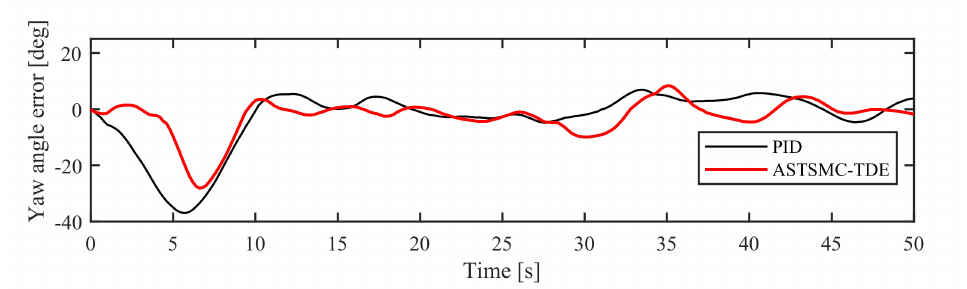
Figure 20. The experimental yaw angle error in NM mode.